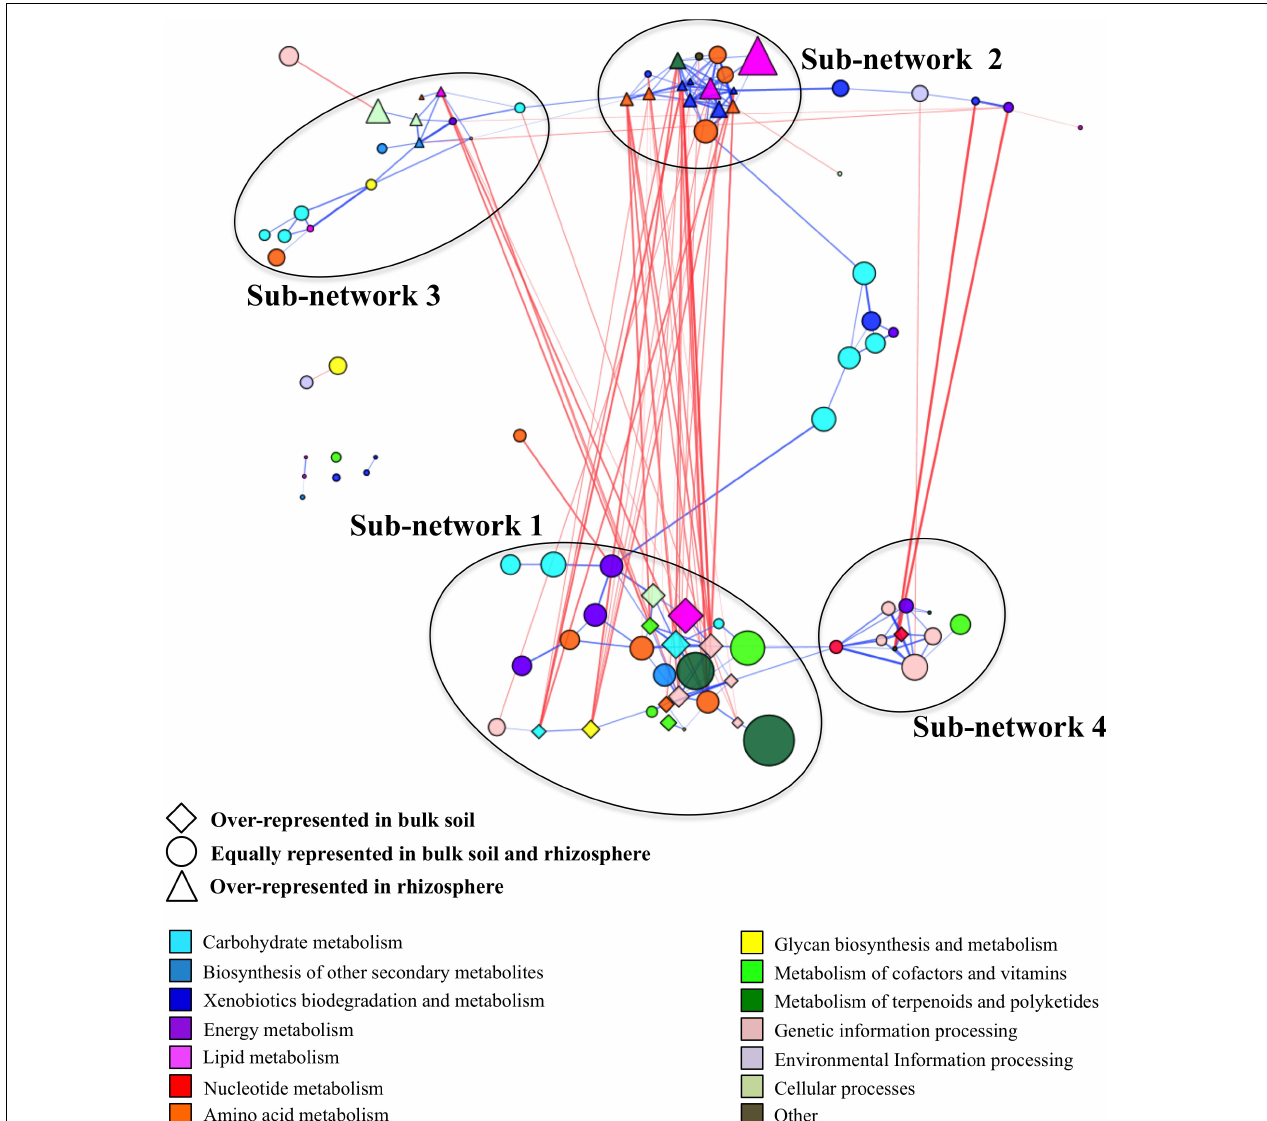
FIGURE 2 | Co-occurrence network generated based on pathway relatively abundances in term of reads per kilobase per genome equivalent (RPKG) within bulk soil and rhizosphere samples. The size of the node is proportional to each pathway’s relative abundance across all samples. The lines (i.e., edges) connecting nodes represent a co-occurrence relationship that can be either positive (blue) or negative (red). The intensity of the color and the length of the edges represent the strength of relationship. The positions of the nodes within modules were manually adjusted for better